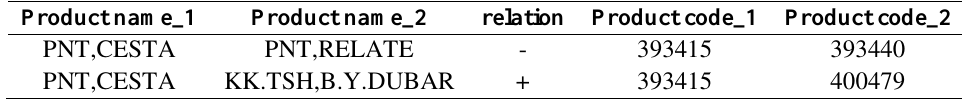
Table 7. Example multiproduct